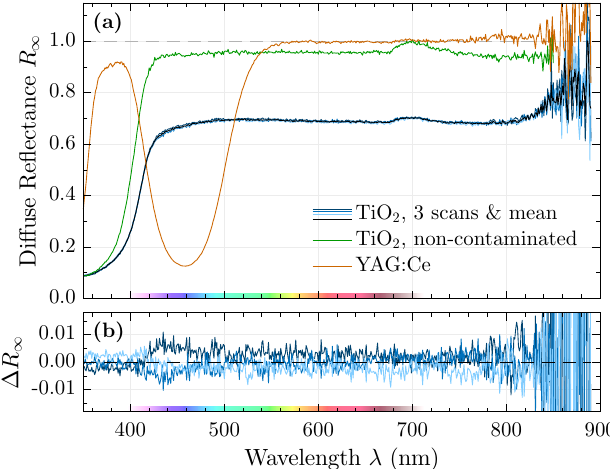
Figure 7. ( a ) Diffuse reflectance spectra of contaminated and nominally pure TiO 2 as well as YAG:Ce against the white standard CR30F . The contaminated sample was scanned three times to highlight the reproducibility of the measurement. Note: The spectral bumps around 700nm arise from an artifact and will be explained in the accompanying text. ( b ) Absolute deviation of the three contaminated TiO 2 scans from their mean